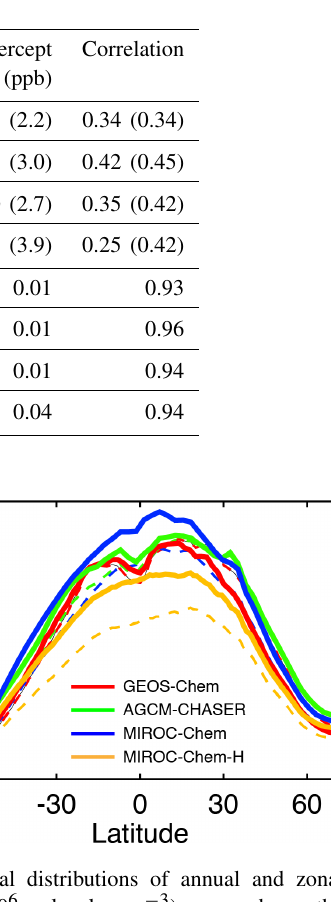
Table 7. Linear regression of changes in surface NO x emissions (10 − 11 kgNm − 2 s − 1 ) and surface concentrations of ozone and NO 2 (ppb) by data assimilation in May 2007 over areas with NO x emission changes greater than 5 × 10 − 13 kgNm − 2 s − 1 in the four models. The results for regions without strong NO x emission changes (greater than 3 × 10 − 11 kgNm − 2 s − 1 that could suffer from dilution effects) are shown in brackets.